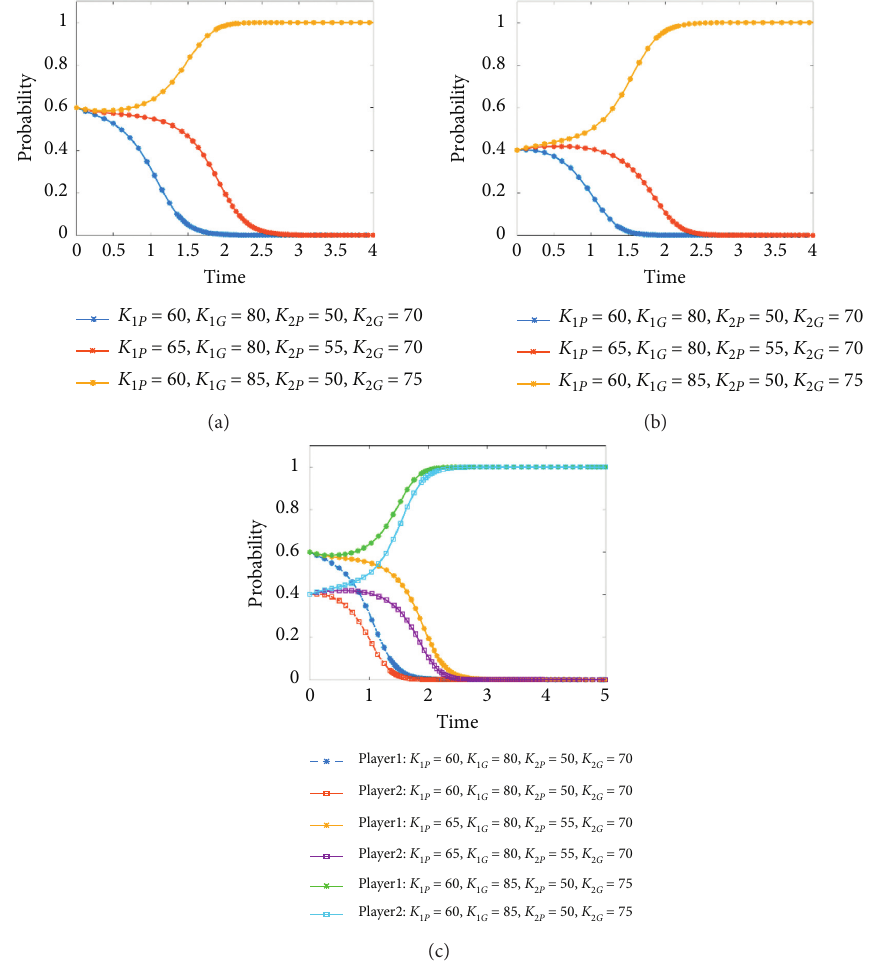
Figure 8: The dynamical evolutionary processes of the probability of knowledge sharing for different professional and general knowledge capacity: ① when professional knowledge capacity increases from K knowledge capacity increases from K (c) the results for both